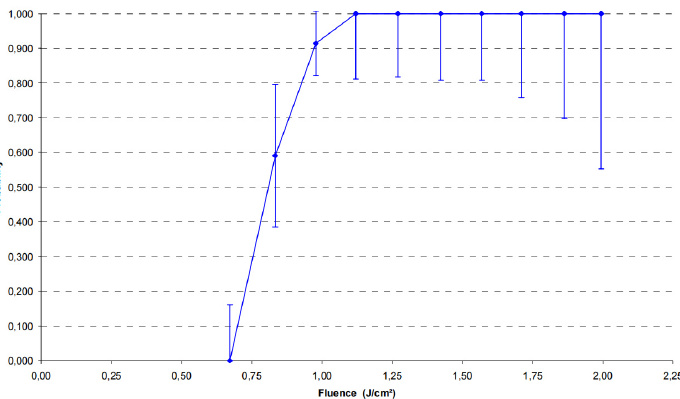
Figure 12. Example of damage probability on a 1740 lines/mm gold grating. Testing was performed at an incidence of 72.5° in TM polarization mode. The damage threshold (maximum value at which the damage probability is null) is 0.67 J/cm 2 .